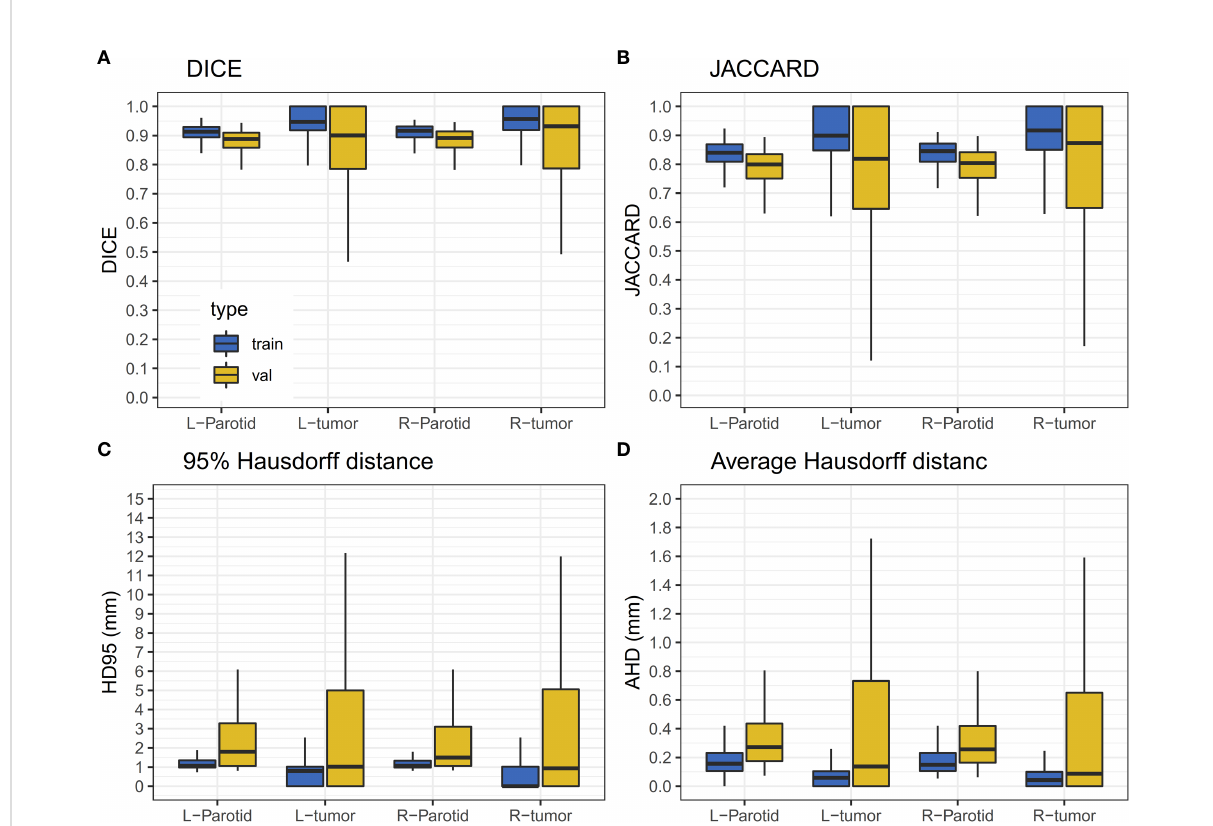
FIGURE 3 Resultsofthevalidationdataset.Thehorizontallinesindicatethemedianvalues. (A) TheDICEvalueforthetrainingandvalidationdataset. (B) JACCARDvalue forthetrainingandvalidationdatasets. (C) TheHD95valueforthetrainingandvalidationdatasets. (D)